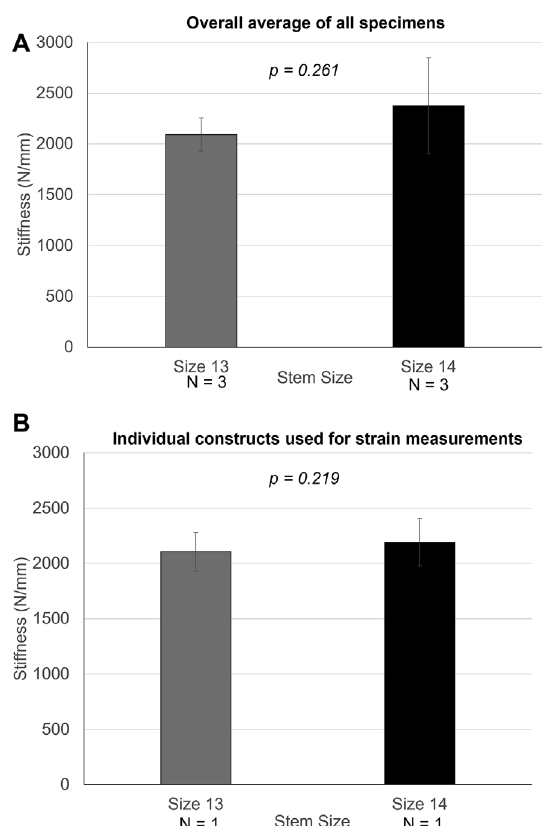
Figure 2. (A) Comparison of overall average stiffness between size 13 and 14 uncemented stem specimens based on the overall average. (B) Comparison of average stiffness between individual constructs of size 13 and size 14 stems. Asterisk (*) denotes the statistical difference between the two variables ( P <